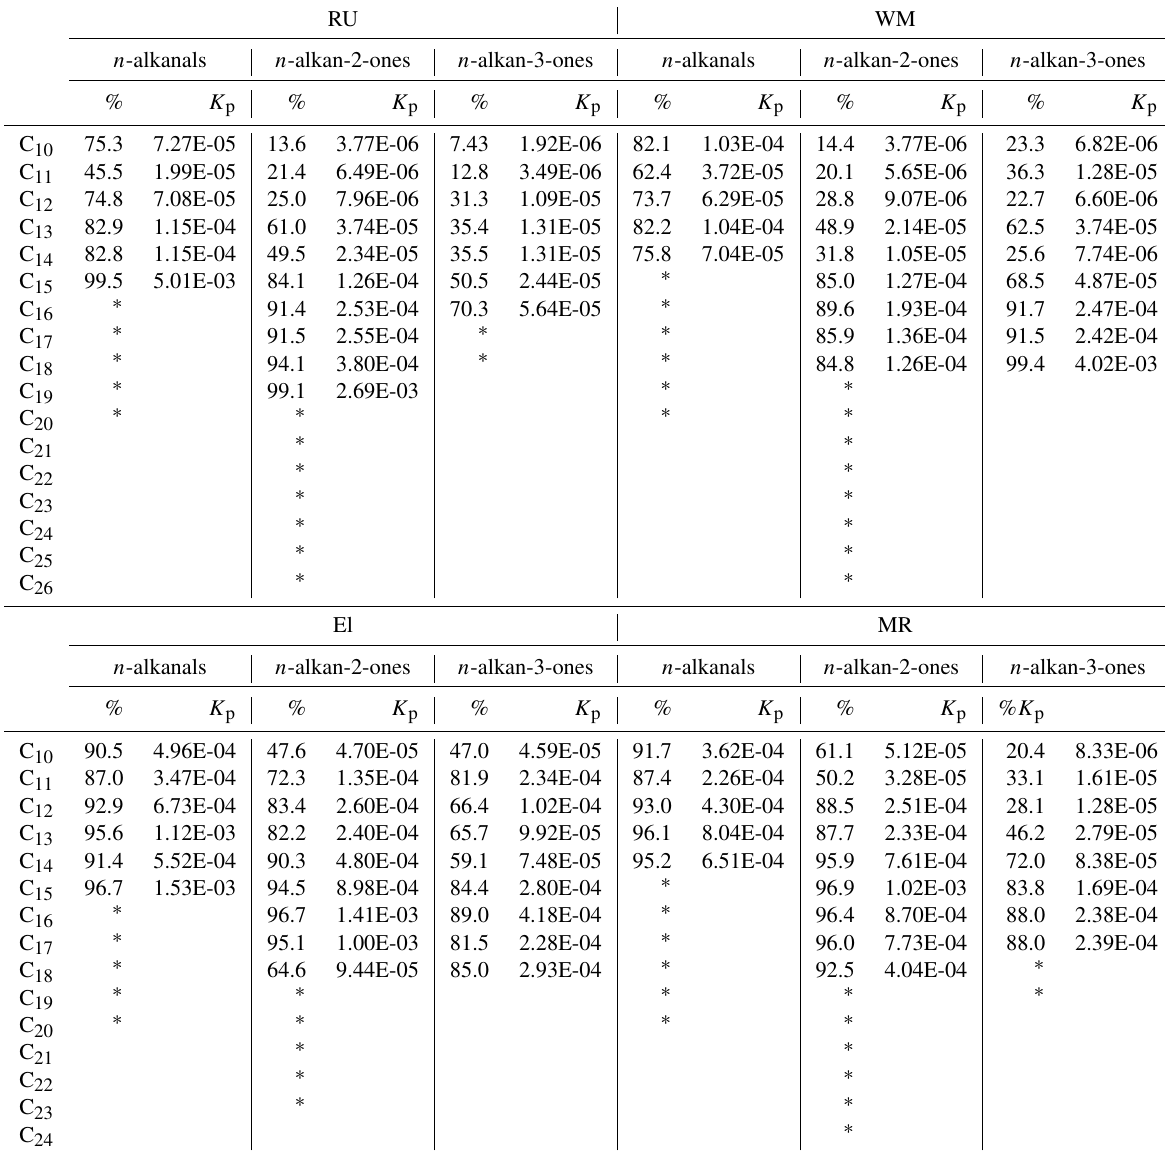
Table 2. Percentages of particle-phase form and the partitioning coefficient K p (m 3 µg − 1 ). RU WM n -alkanals n